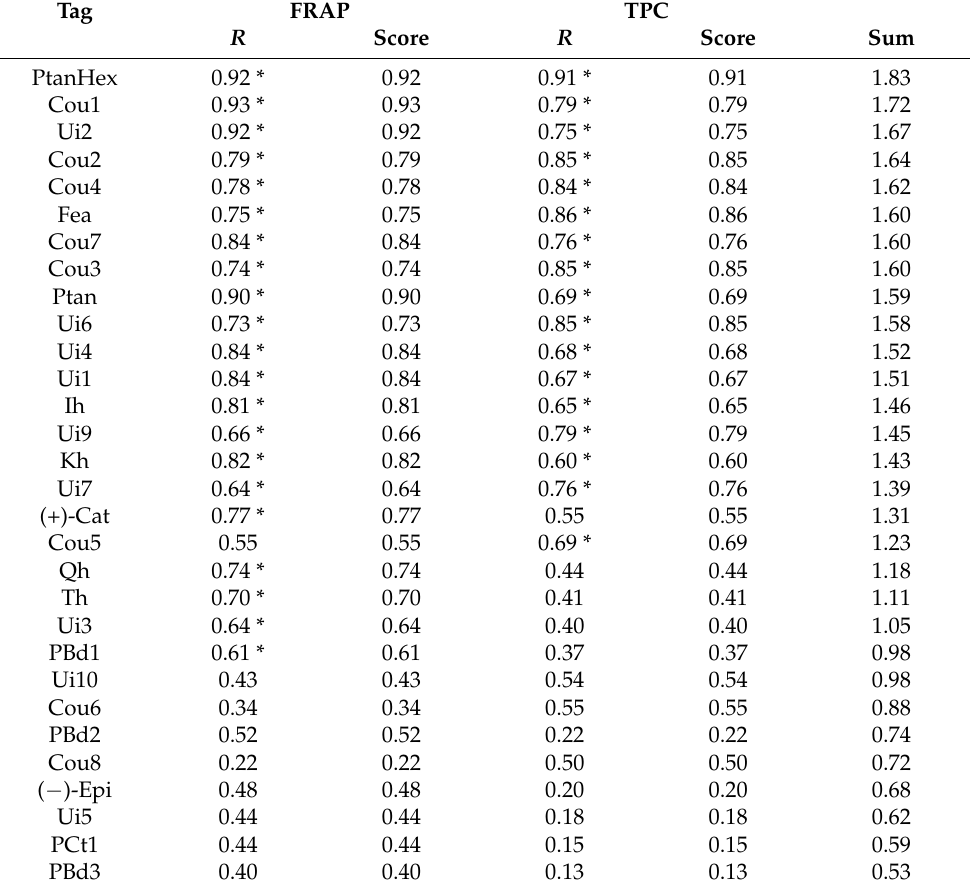
Table 2. Correlation analysis of the polyphenol peak areas and antioxidant properties of Norway spruce cone extracts. Significant correlations (for p < 0.05, n = 11, | R | ≥ 0.60) were marked with an asterisk. FRAP: Ferric Reducing Antioxidant Power; TPC: Total Polyphenol Content. For the interpretation of tags please refer to Table